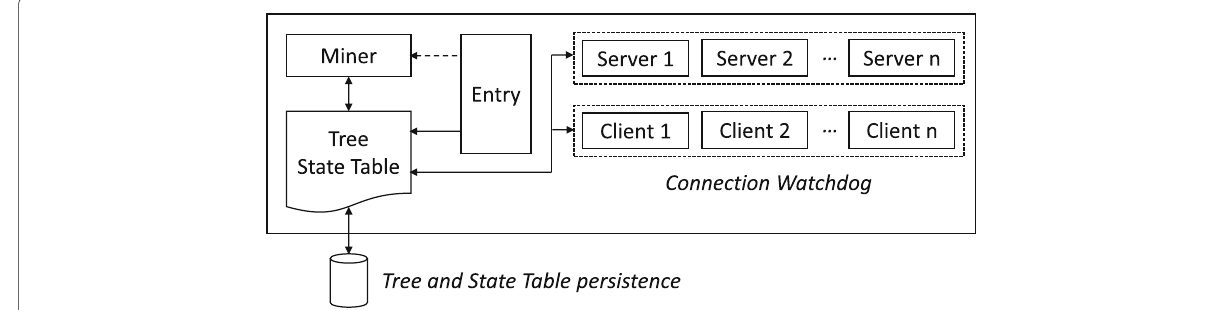
Fig. 2 Program overview: The mining thread as well as up to n server threads and up to n client threads operate on the core tree data structure representing the blockchain and the state table representing the assignments of portions. The state of the data structure as well as auxiliary representations like time-slot-accurate portion assignments are persisted to disk. Server and client threads include watchdogs to detect and potentially resume lost connections to other